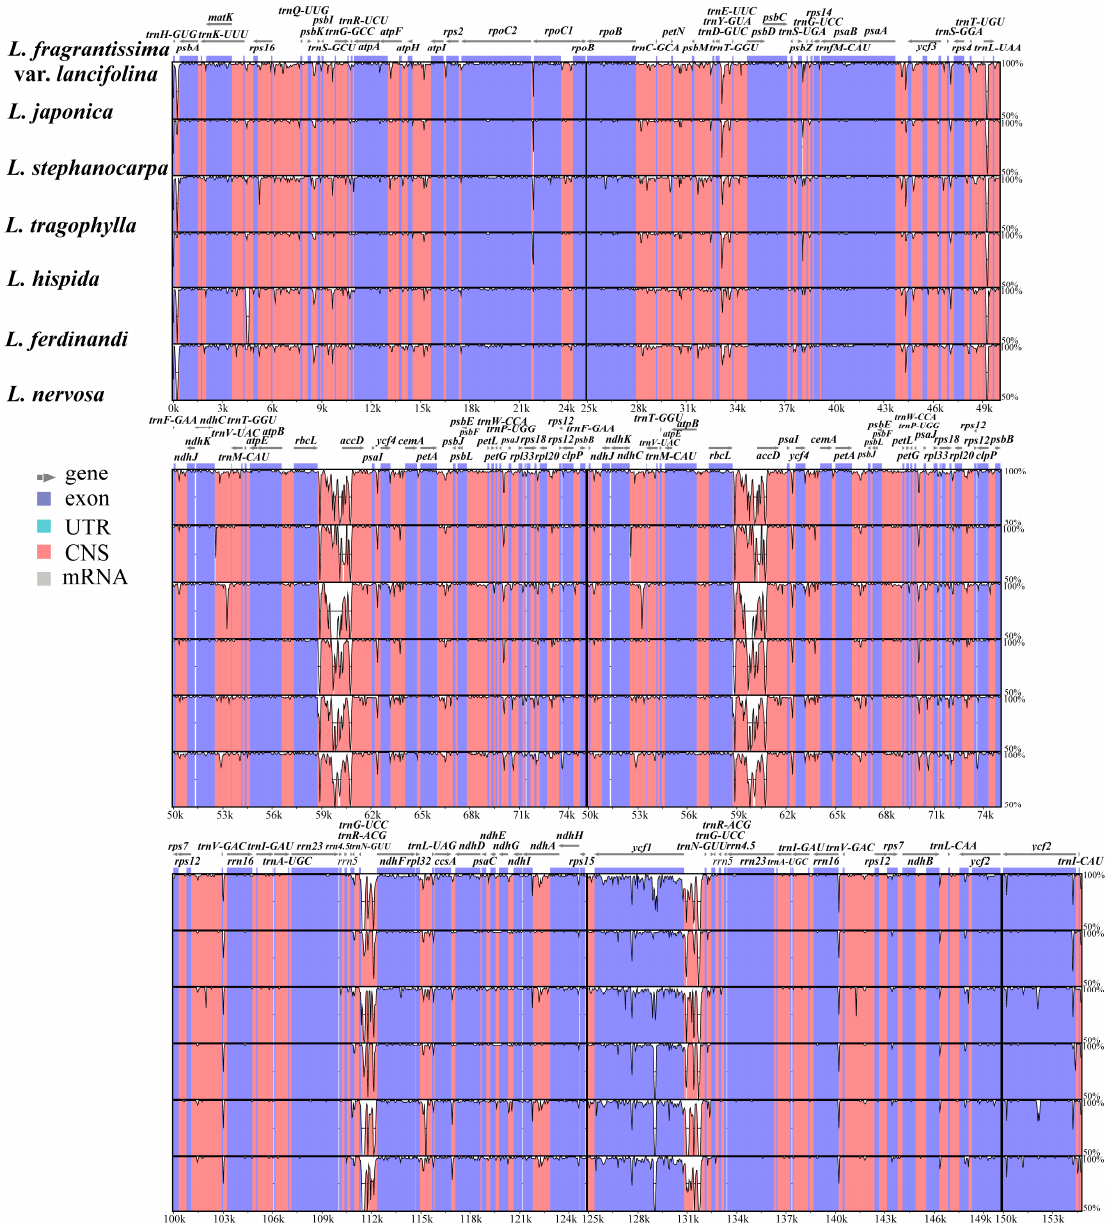
Figure 5. Sequence alignment of chloroplast genomes from seven Lonicera species. Sequences of chloroplast genomes were aligned and compared using the mVISTA program. The horizontal axis (x) indicates the coordinates within the chloroplast genome. The vertical scale (y axis) indicates the percentage identity, ranging from 50 to 100%. The grey arrows indicates the direction of each gene. Purple bars represent exons, orange bars show conserved non-coding sequences.